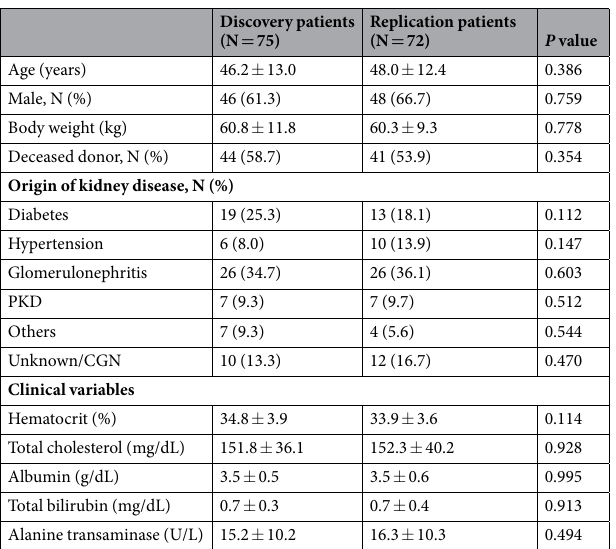
Table 1. Baseline demographic characteristics for included subjects. PKD, polycystic kidney disease; CGN, chronic glomerulonephritis; Data are presented as a number with percentage for categorical variables and a mean with standard deviation for continuous